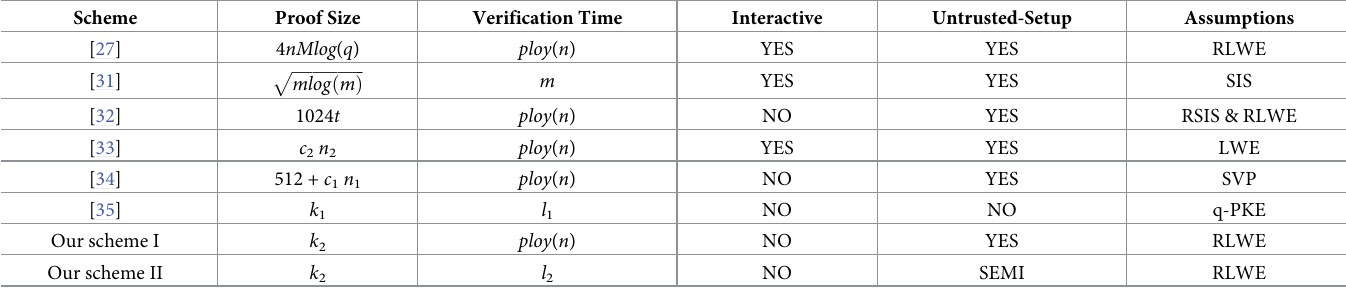
Table 2. Comparison the efficiency of related zero-knowledge proof schemes.